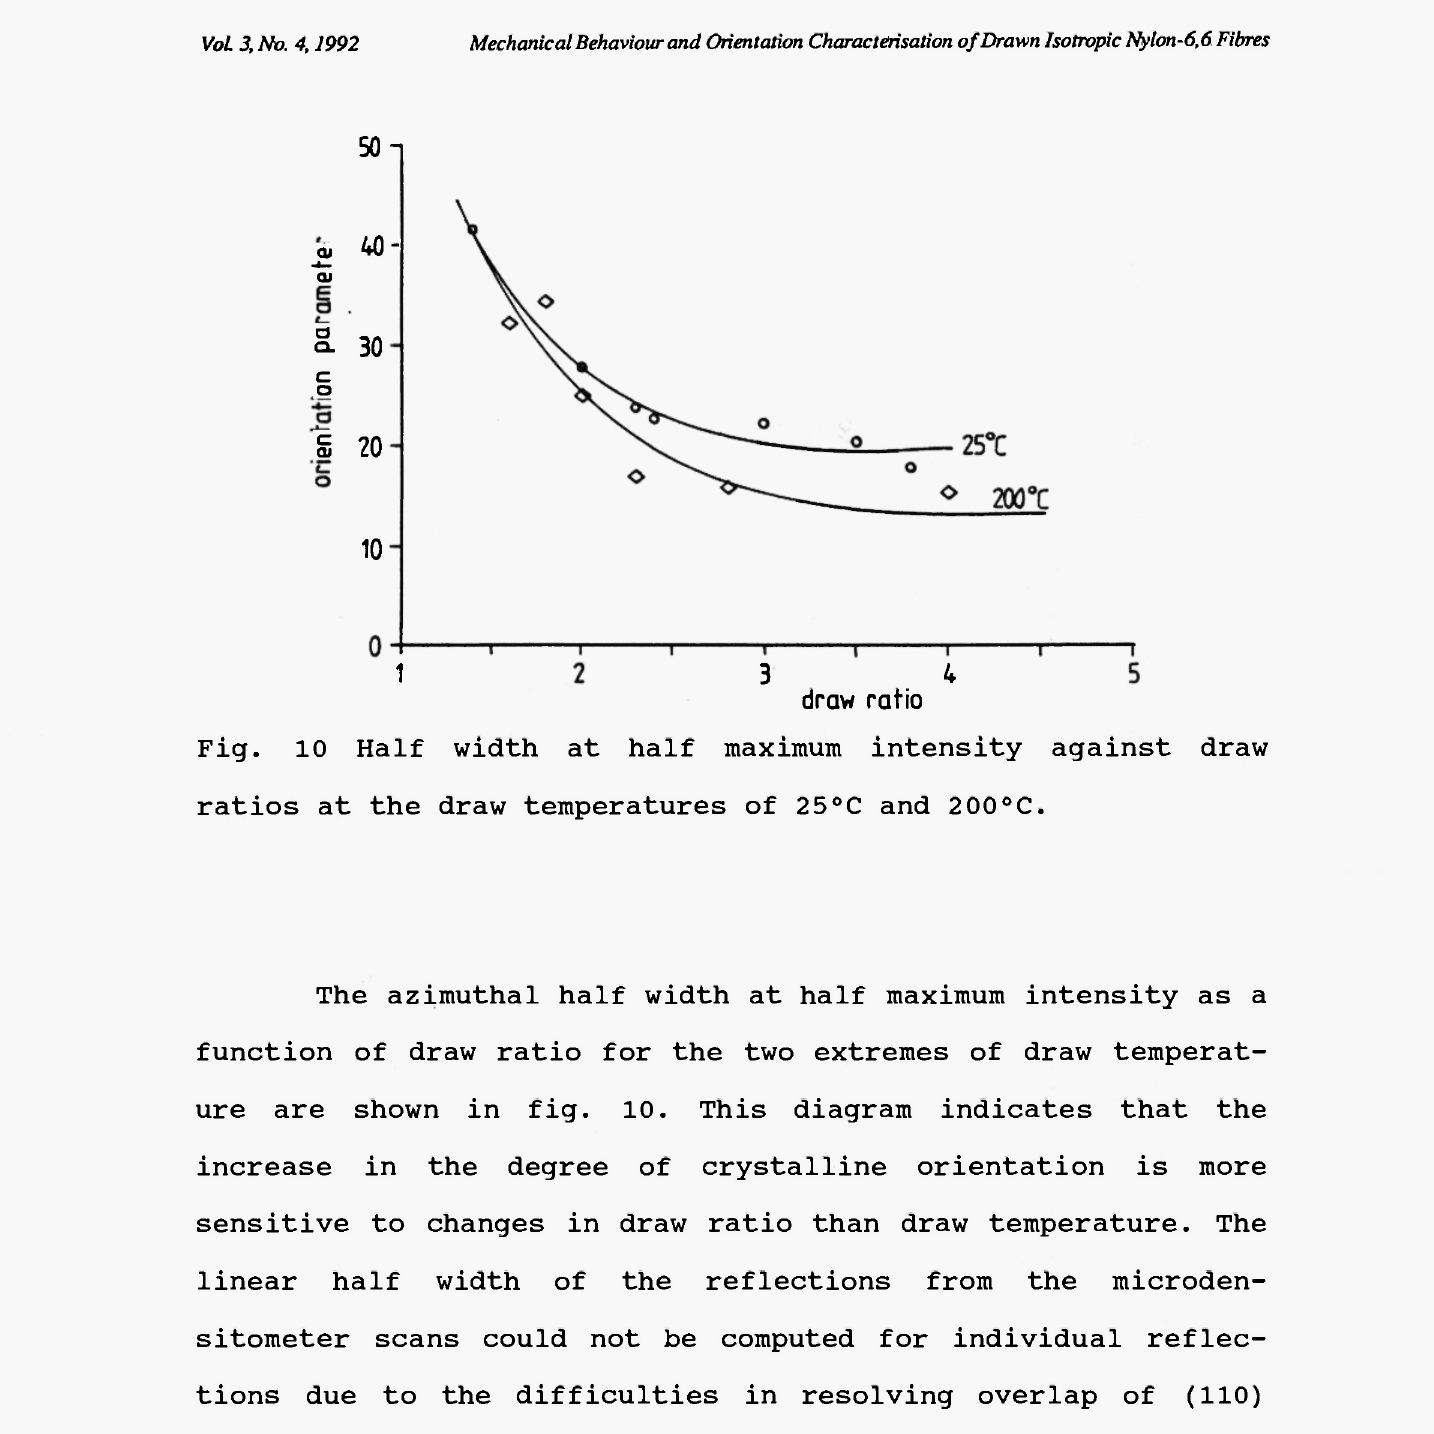
The azimuthal half width at half maximum intensity as a function of draw ratio for the two extremes of draw temperat- ure are shown in fig. 10. This diagram indicates that the orientation is